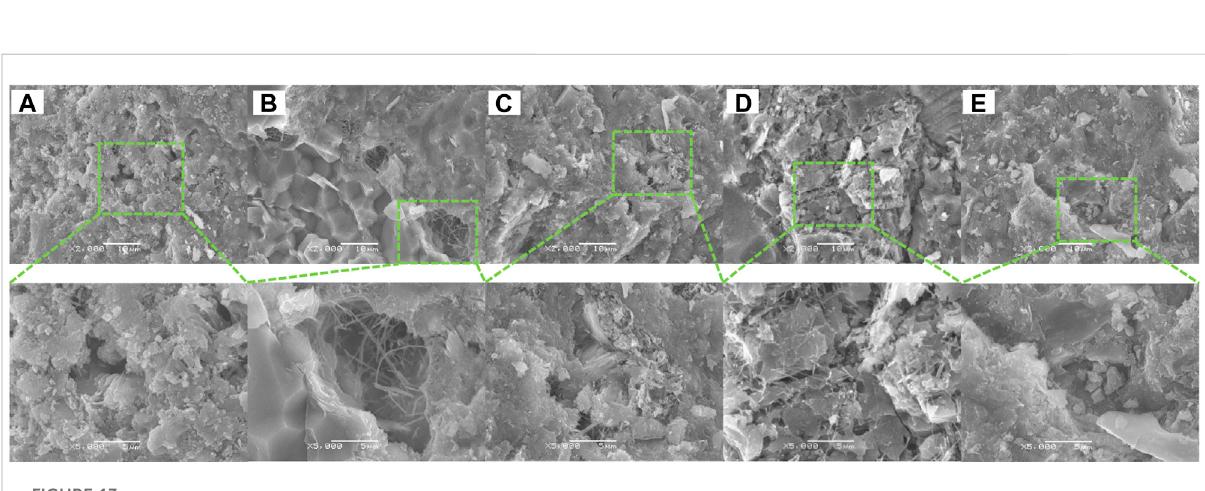
FIGURE 13 Microstructure of concrete erosion products; (A) GS0; (B) GSa; (C) GSb; (D) GSc; (E)